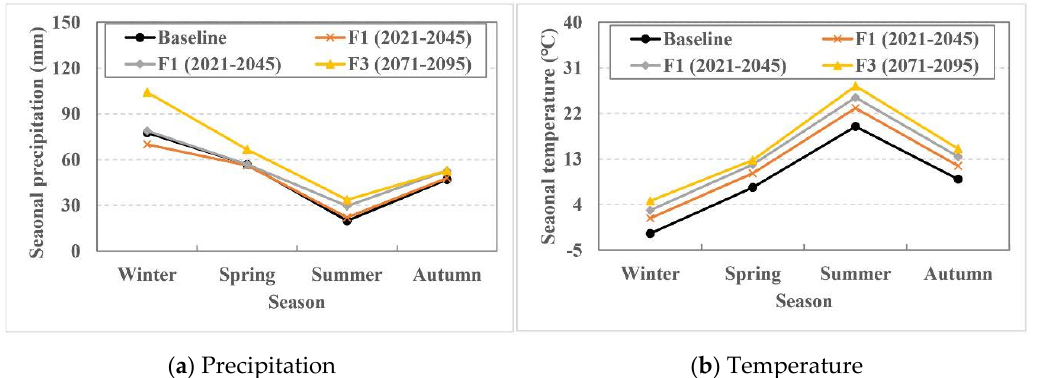
Figure 3. Future precipitation ( a ) and temperature ( b ) variations associated with RCP8.5